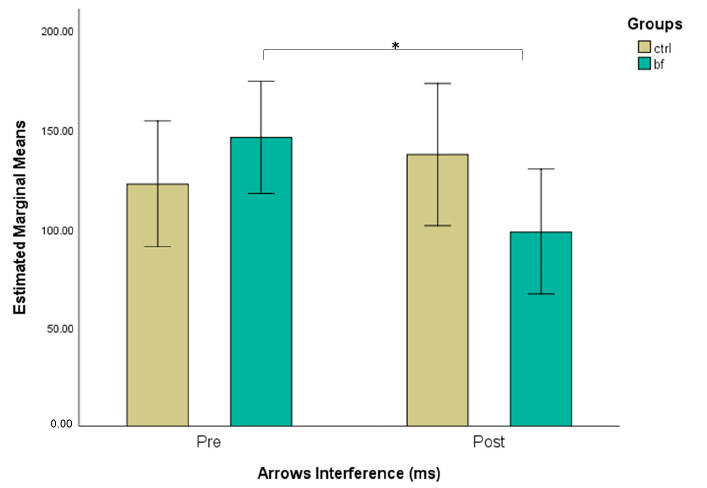
Figure 2. Estimated marginal means (with 95% confidence intervals) for Arrows Interference pre ‐ and post ‐ intervention across groups (*— p < 0.05—T ‐ test for dependent samples). post-intervention across groups (*— p < 0.05— t -test for dependent